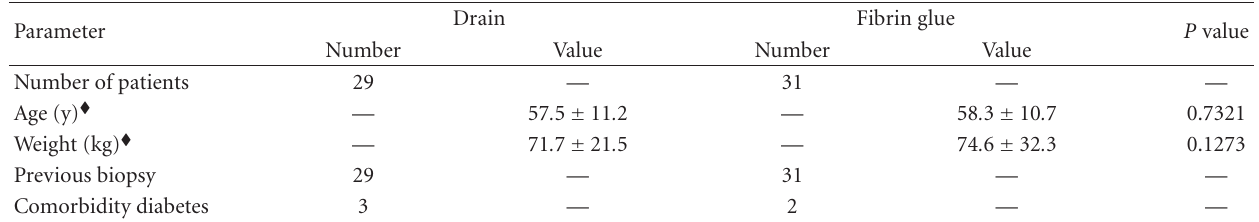
Table 1: Comparison of demographic data and comorbid conditions for control (drain) and fibrin glue groups. Parameter